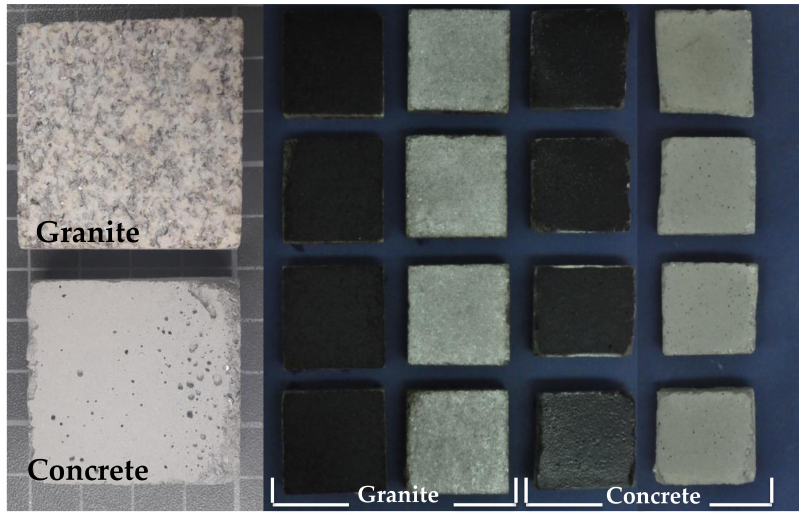
Figure 3. Uncoated and coated specimens of natural and man-made